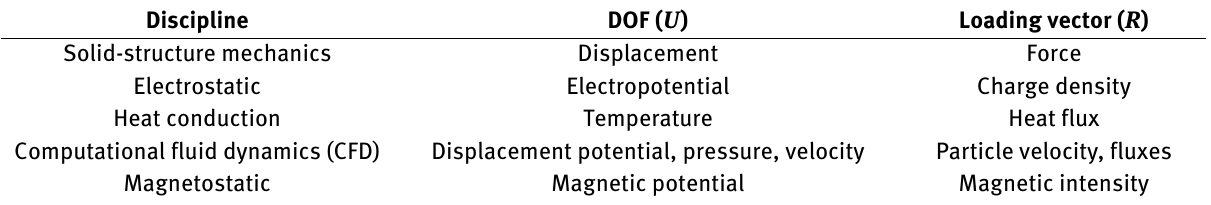
Table 2: Degrees of freedom (DOF) and loading vectors for different disciplines using FEM